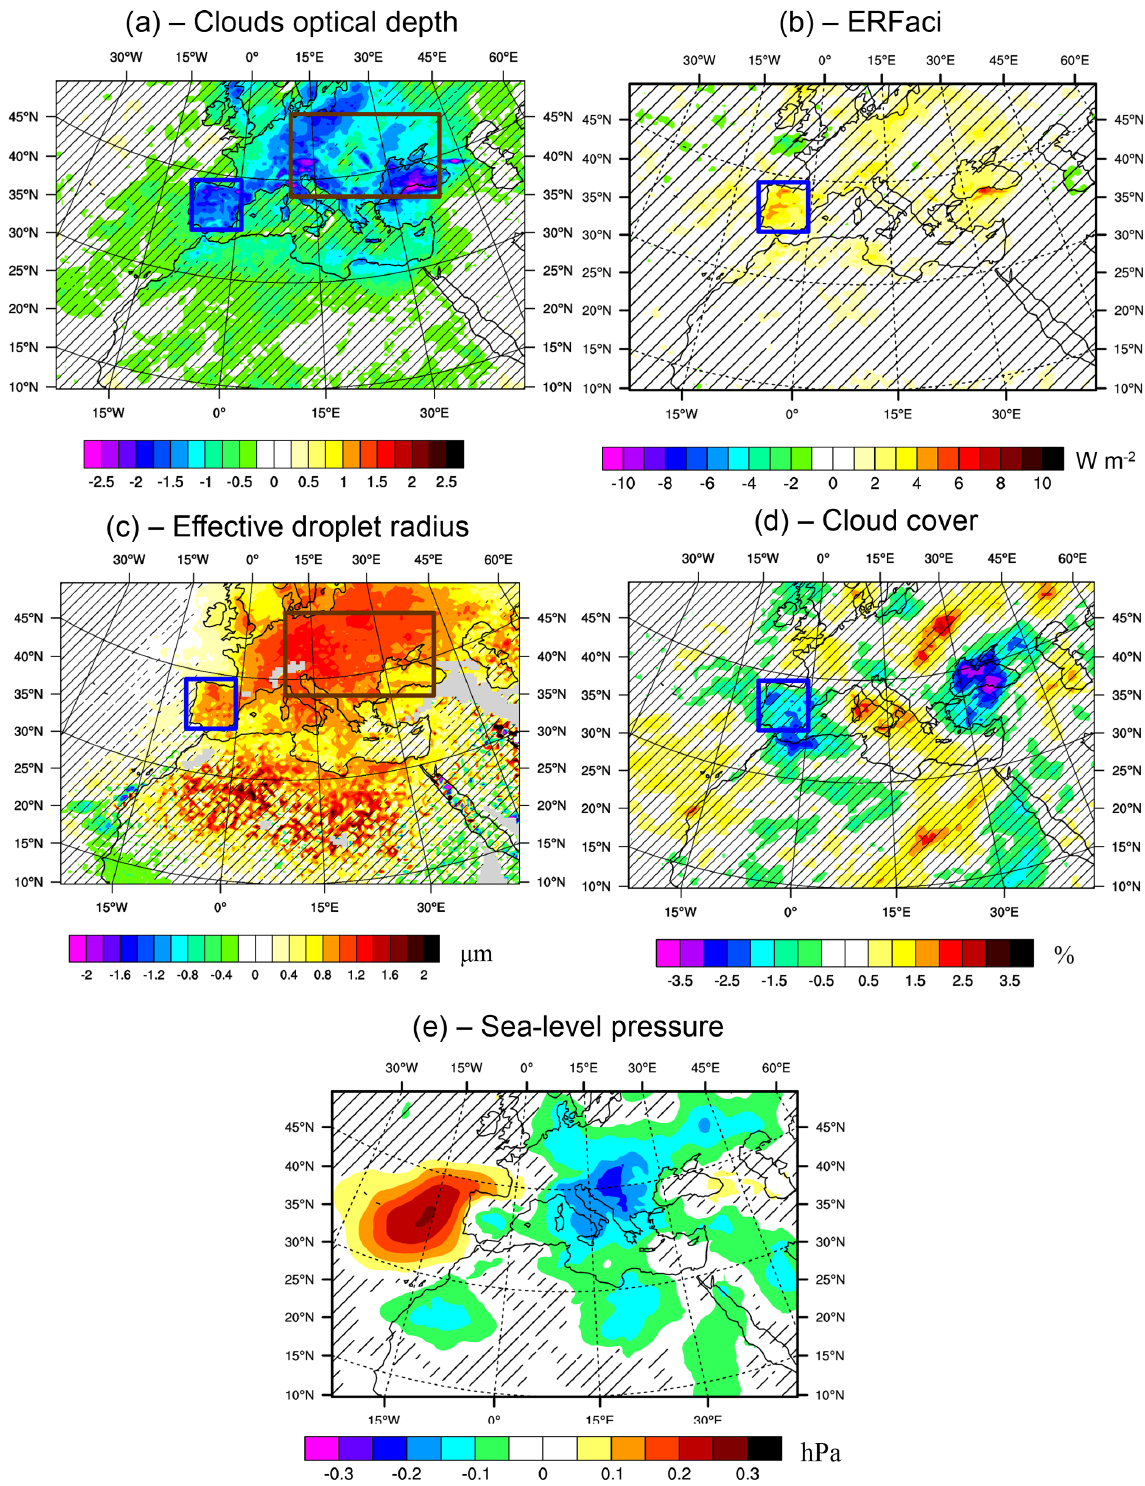
Figure 14. Mean differences for the months of June, July and August between SSP585 and SSP585cst simulations over the period 2021–2050 for the cloud optical depth (a) , the effective radiative forcing due to aerosol–cloud interactions (ERFaci, Wm − 2 , b ), the effective droplets radius (µm, c ), the cloud cover (%, d ) and the sea-level pressure (hPa, e ). The brown frame represents Central Europe and the blue frame locates the Iberian Peninsula. The hatched areas are statically non-significant with a threshold of